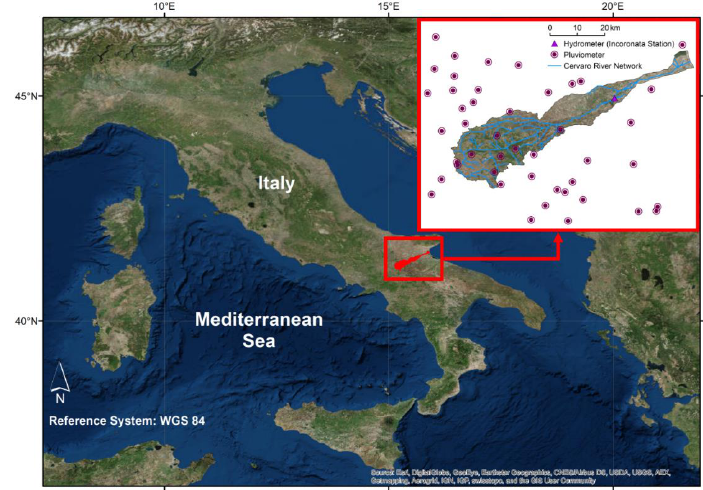
Figure 1. Geographic location of the Cervaro River Catchment. The red box gives a detailed representation of the Cervaro River Catchment, in which the hydrological network and the reference hydrometric station (Incoronata station) are also shown. Catchment boundaries and river network were provided by Istituto Superiore per la Protezione e la Ricerca Ambientale (ISPRA) [57].